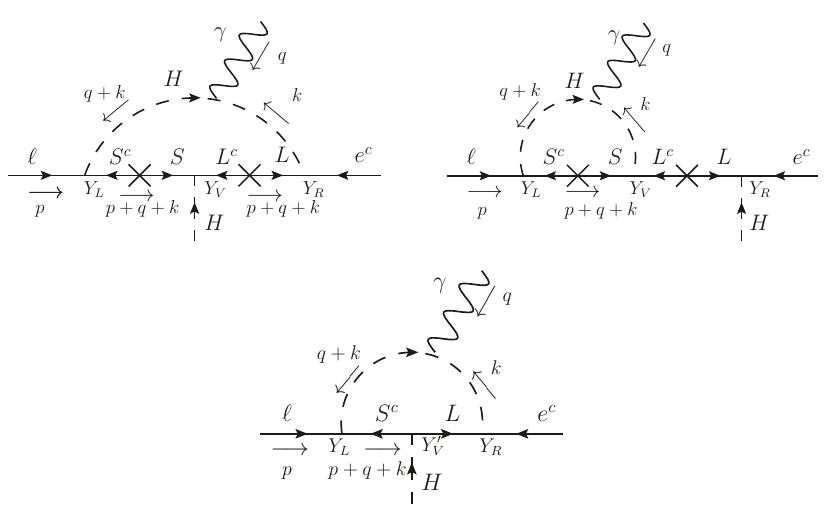
Figure 1 . Leading diagrams for ( g − 2) µ . While these diagrams naively generate dimension-six operators, the bottom diagram, and the sum of the top two diagrams, actually give vanishing leading contribution to ( g − 2) µ